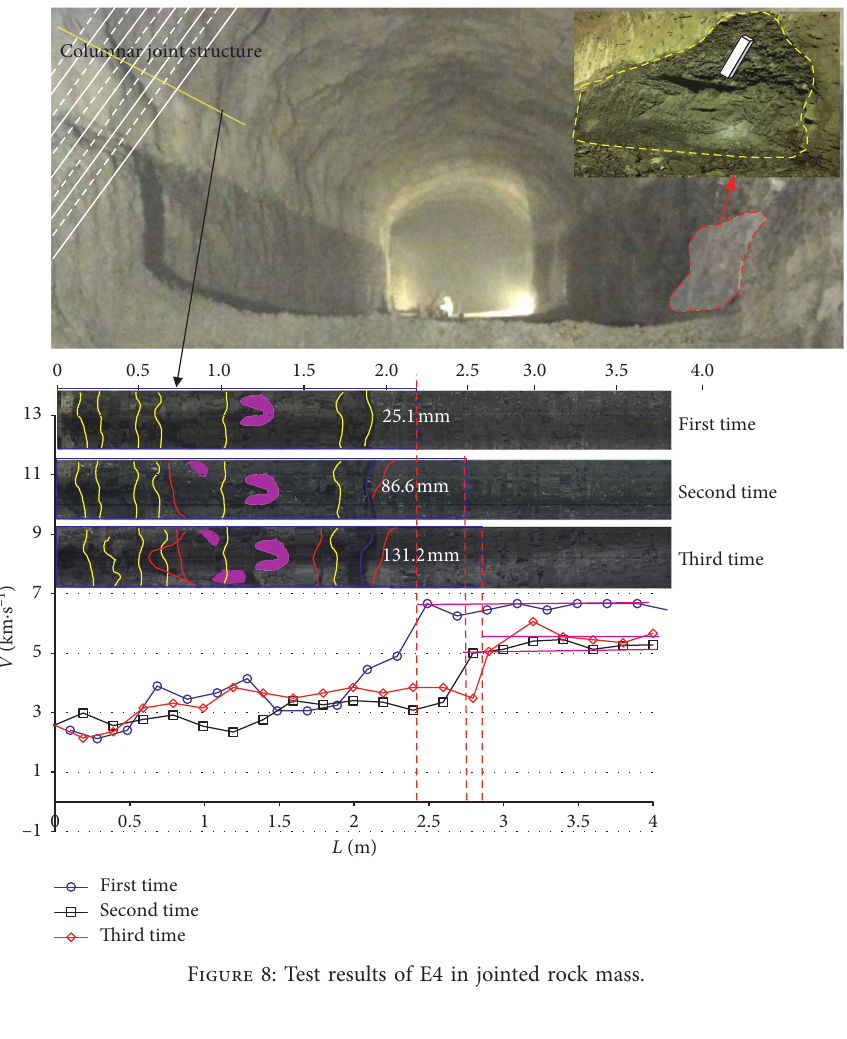
Figure 8: Test results of E4 in jointed rock mass.